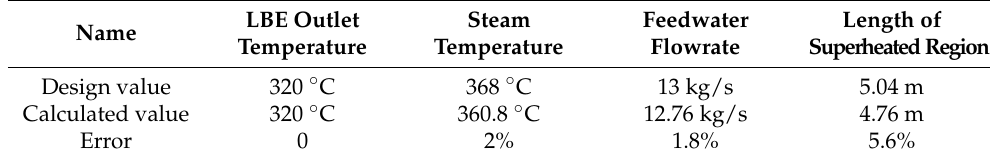
Table 3. Model calculation results at 100%